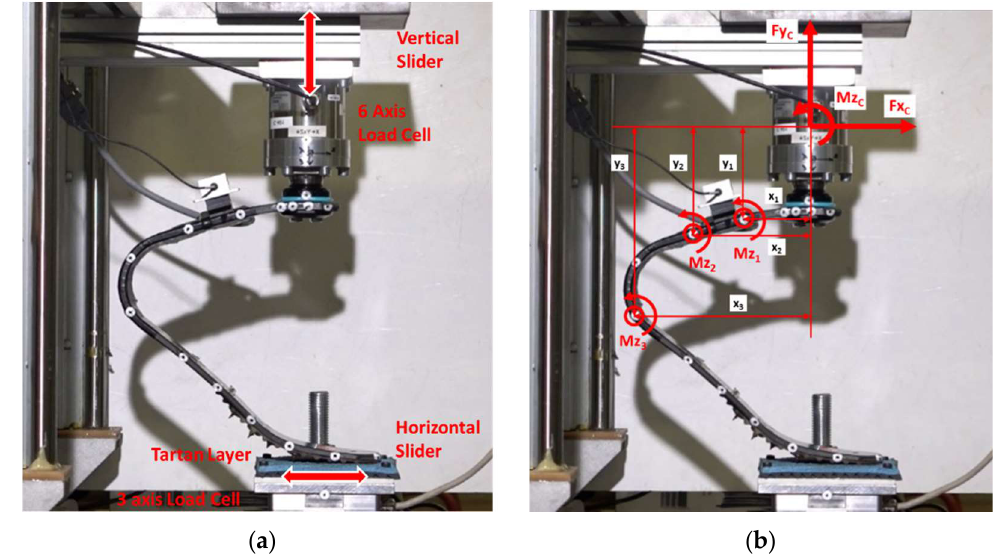
Figure 6. Calibration method of the instrumented RPF: ( a ) the instrumented running prosthetic foot (iRPF) is clamped to a 6-axis load cell and loaded from a controlled vertical slider against a controlled horizontal slider equipped with a 3-axis load cell covered with tartan and ( b ) moments Mz i applied to the three bending bridges are calculated from the combination of load cell loads and the instantaneous location of the bridges expressed by the coordinates x and y of each bridge in the load cell system of reference.